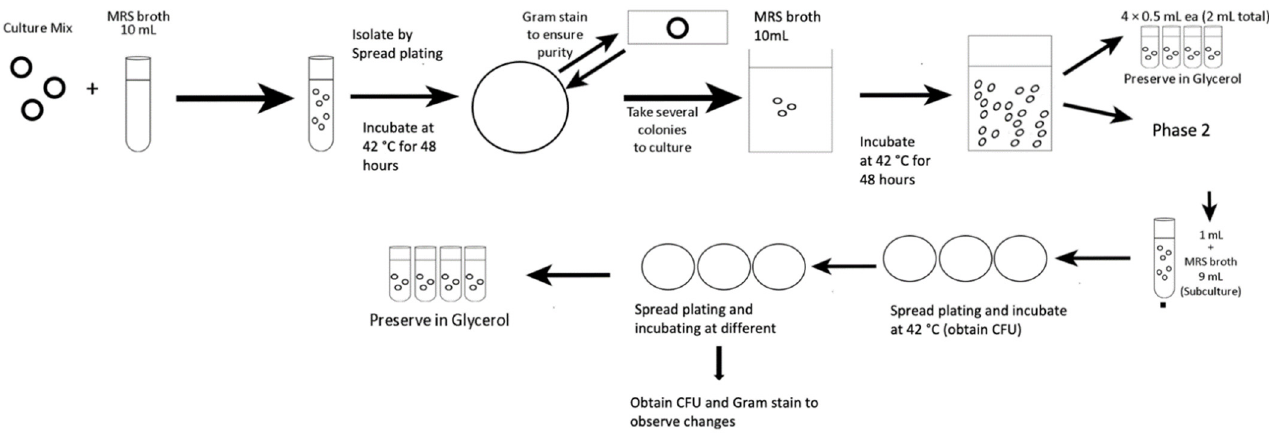
Figure 1. Flow diagram of isolation of L. bulgaricus pure culture at 42 °C and thermo-tolerant L. bulgaricus induction at 52 °C.